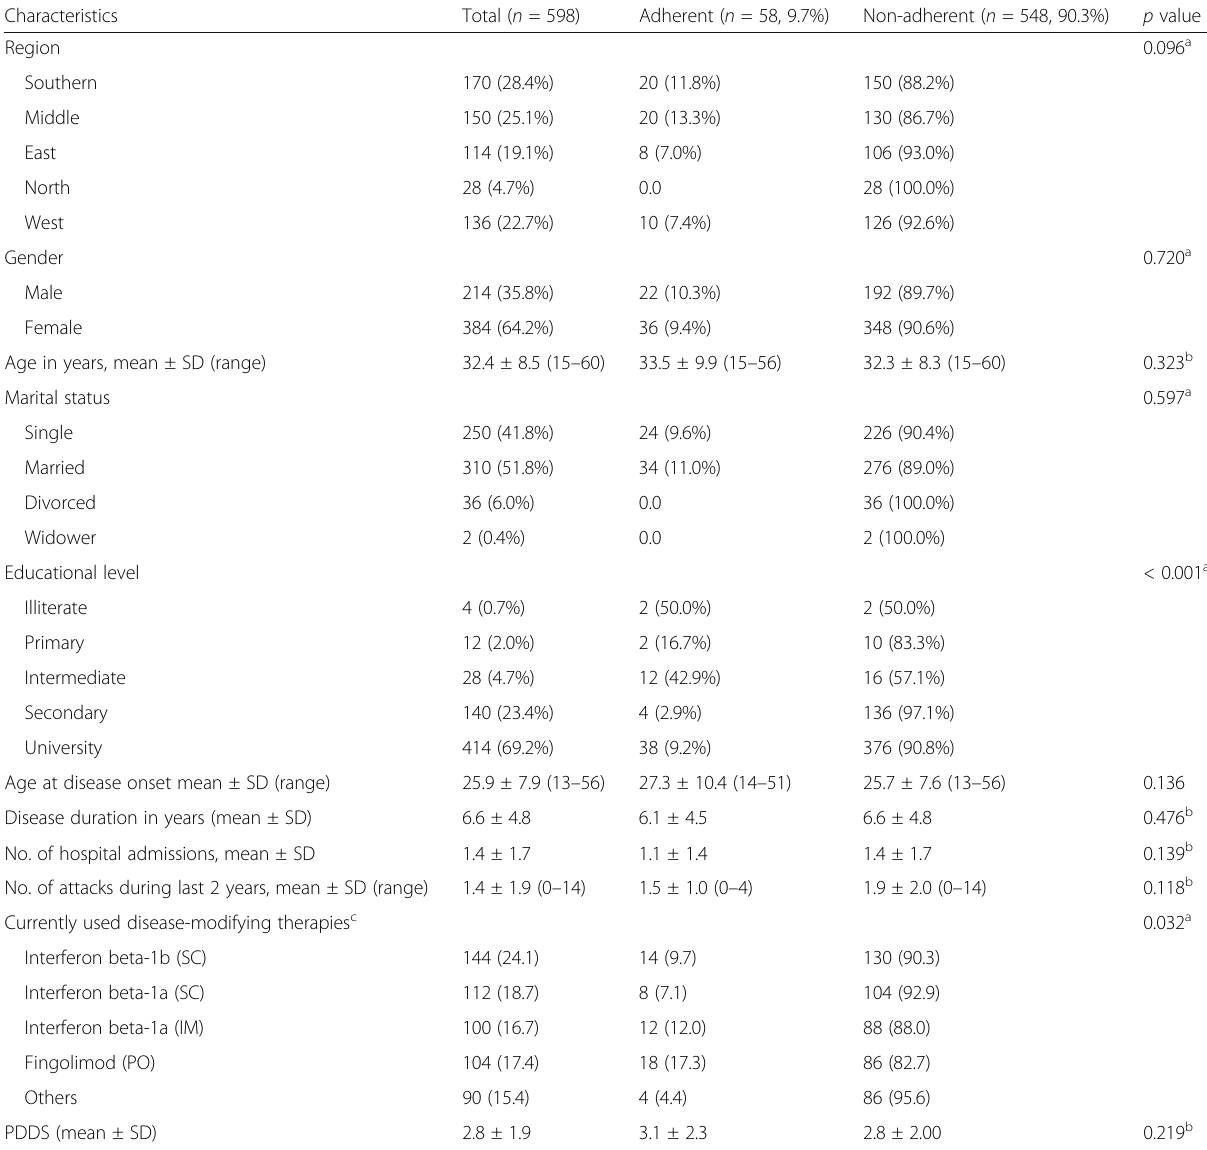
Table 1 Socio-demographic and clinical characteristics of MS patients according to their medication adherence ( n = 598)